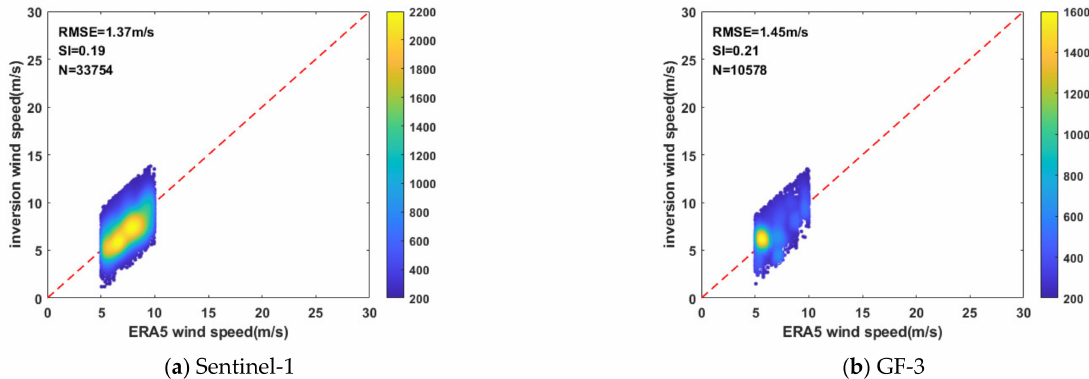
Figure 6. SAR data inversion results of Sentinel-1 and GF-3 when the wind speed is 5~10